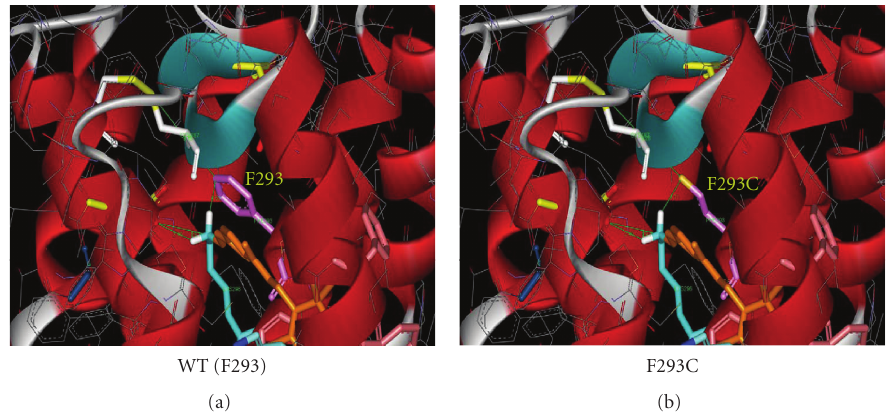
Figure 9: Crystal structure analysis of allelic variant constructs. We analyzed the location of the F293C mutation in the bovine rod opsin crystal structure (1F88.pdb). WT protein (a). The image shows the cutout region around the protonated Schi ff base linkage of 11- cis- retinal (orange) to K296 (blue sidechain). F293 is lavender in color. The disulfide bond between C110 and C187 is in yellow. F293 is within 5 ˚A of the Schi ff base and within 10 ˚A of the disulfide bond. F293C Mutation (b). The C293 sidechain is lavender in color with a yellow tip indicating a free sulfhydryl group (-SH). The SH group is within 5 ˚A of the Schi ff base and 10 ˚A of the disulfide